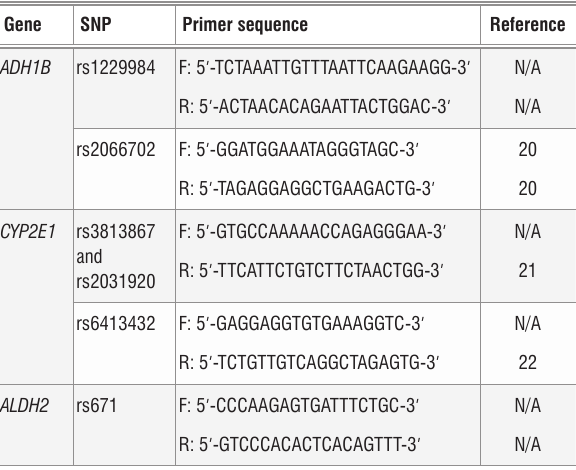
Primers used for polymerase chain reaction (PCR)